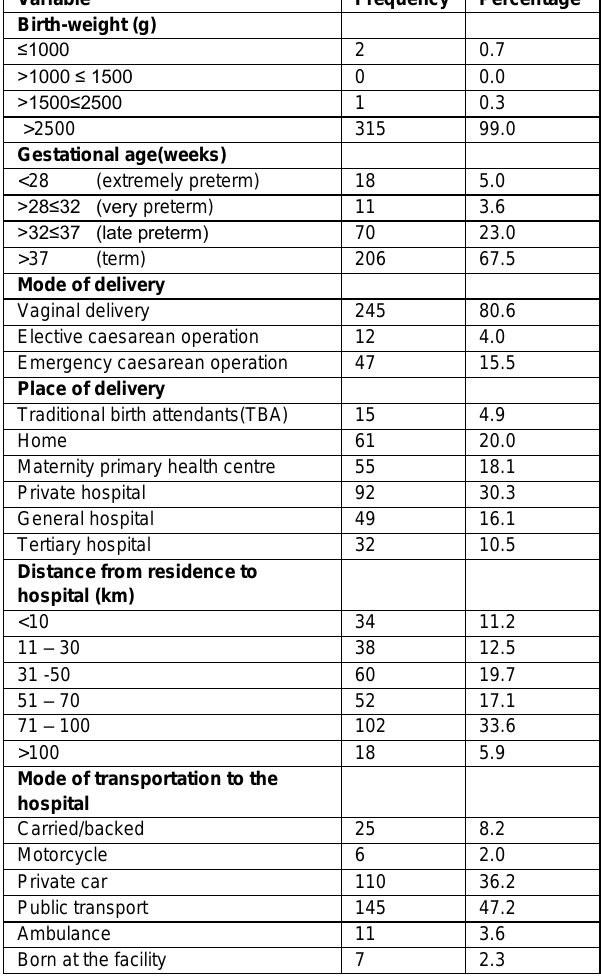
Table 1: Perinatal characteristics and